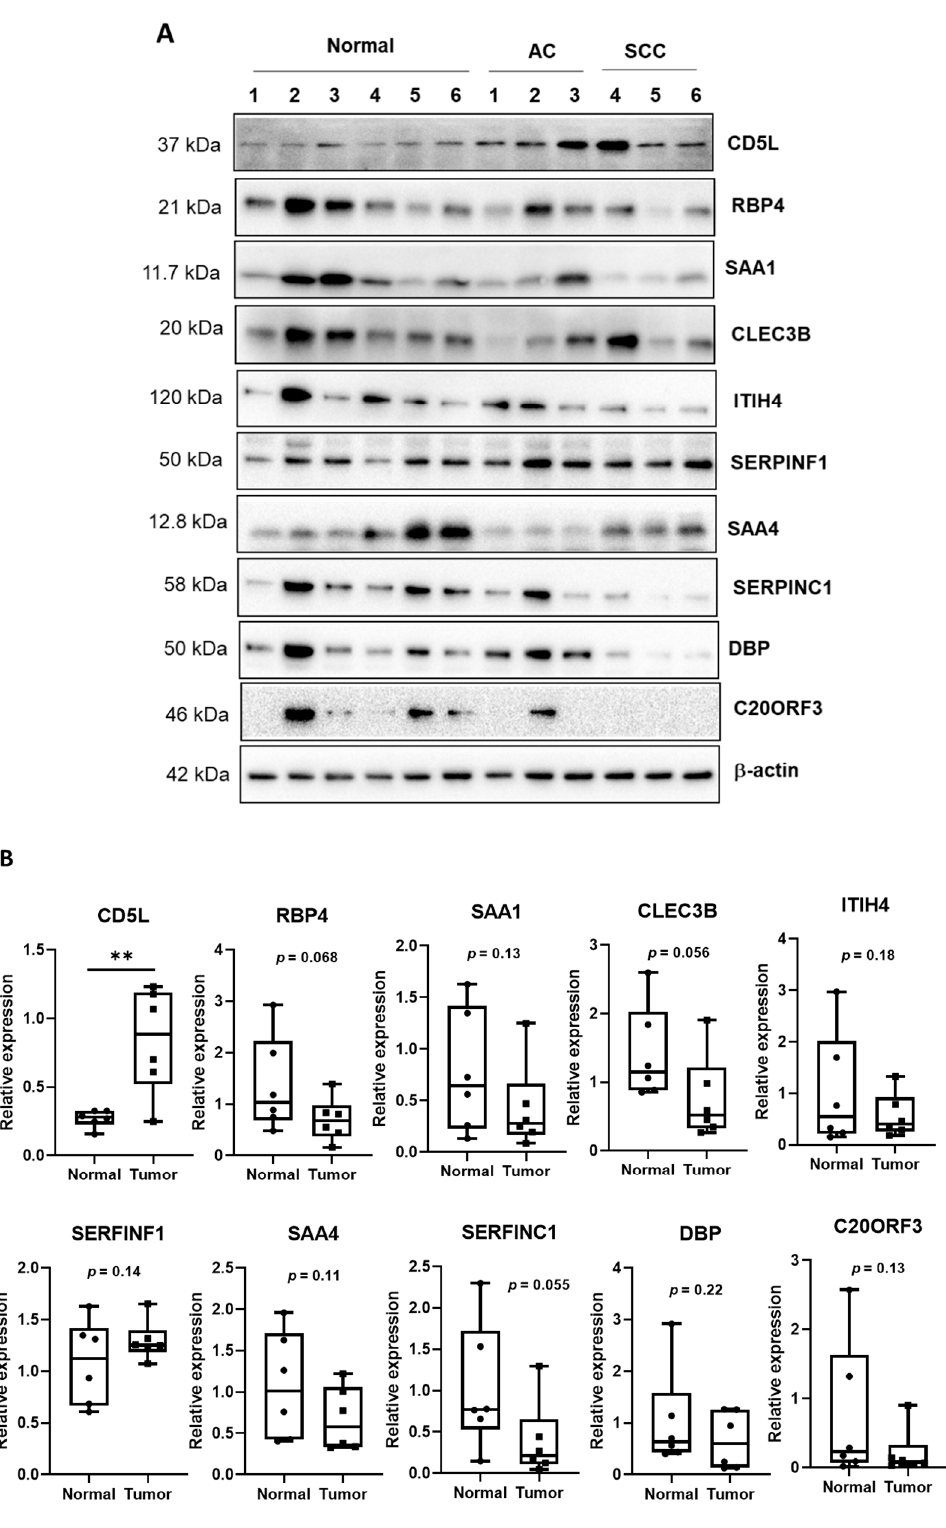
Figure 3. Expression of candidate biomarkers in normal and cancer tissues. ( A ) Western blotting to check for the expression of candidate biomarkers in normal and cancer tissues. The normal tissues were obtained by pairing with cancer tissues from a patient. AC, adenocarcinoma lung cancer; SCC, squamous cell carcinoma. ( B ) Quantitative analysis of Western blot analysis. ** p < 0.01.